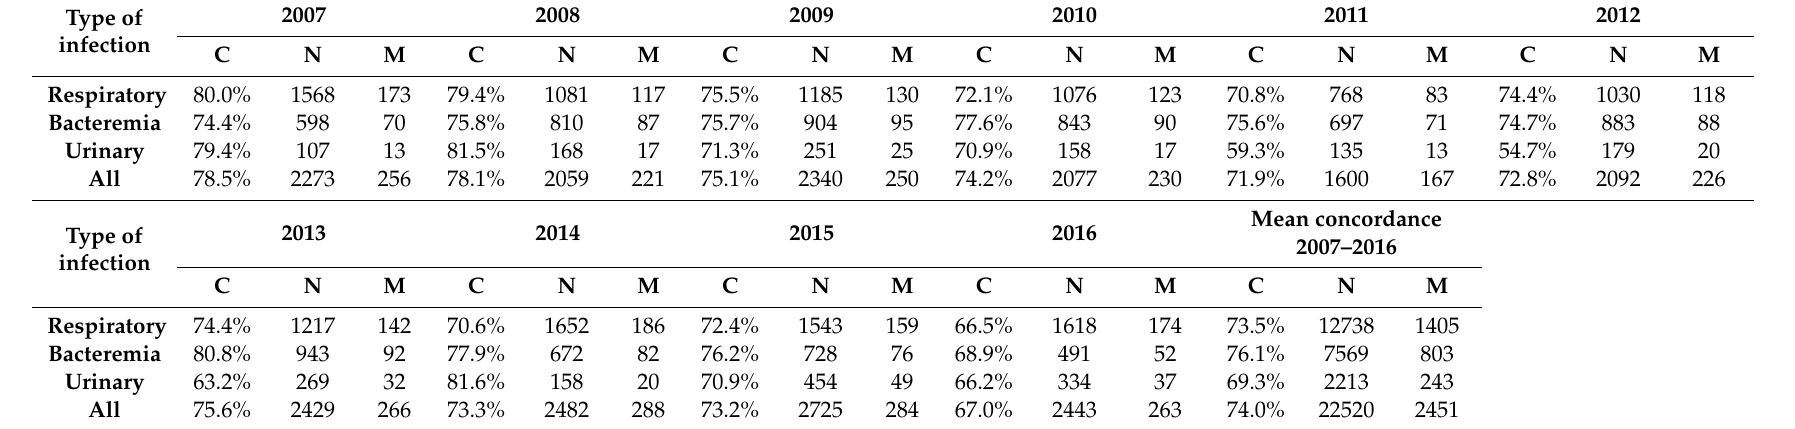
Table 2. Percentage of concordance between bacterial susceptibility depicted by LRMs and that obtained from antibiograms by year and type of infection. 2007 Type of infection Respiratory Bacteremia All Type of infection Respiratory 74.4% Bacteremia Urinary 63.2%